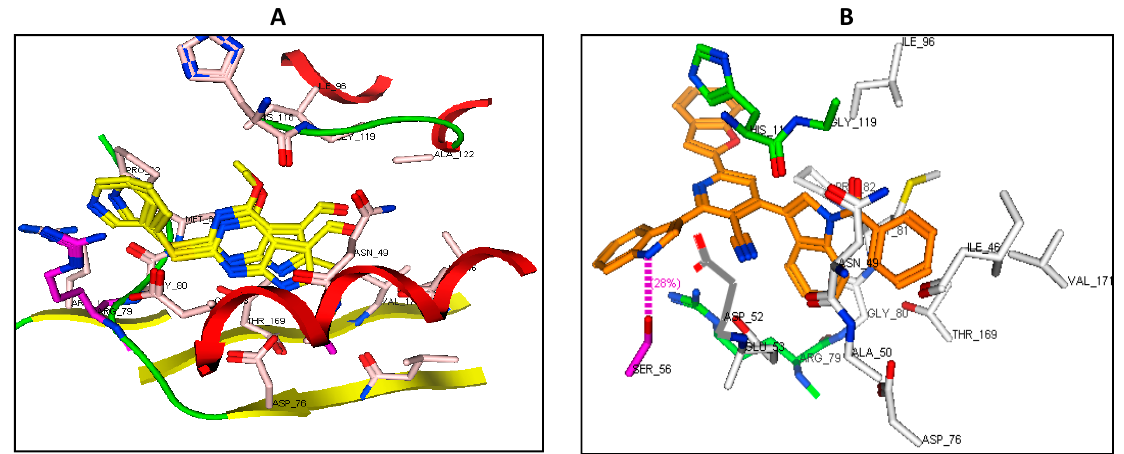
Figure 8. ( A ) The binding mode of the re-docked ligand within the binding pocket of DNA topoisomerase IV subunit B (ID: 4HZ5 ). The re-docked ligand shows superimposed on the same position as the native ligand (yellow, stick) with the same orientation. The two ligands show π -cation interaction with Arg79 (pink, stick); ( B ) The binding mode of compound 7d (brown, stick) within the binding pocket of DNA topoisomerase IV subunit B (ID: 4HZ5 ). Compound 7d shows one H-bond donner with Ser56 (pink, stick) and two π -cation interactions with His118 and Arg79 (green, stick). Table 5. Docking results of the most antimicrobial active compounds 4b , 7a , 7c , 7d , 8e , the native thymidylate kinase (ID: 4QGG), the DNA gyrase B (ID: 6F86), and the DNA topoisomerase IV subunit B (ID: 4HZ5). Comp.